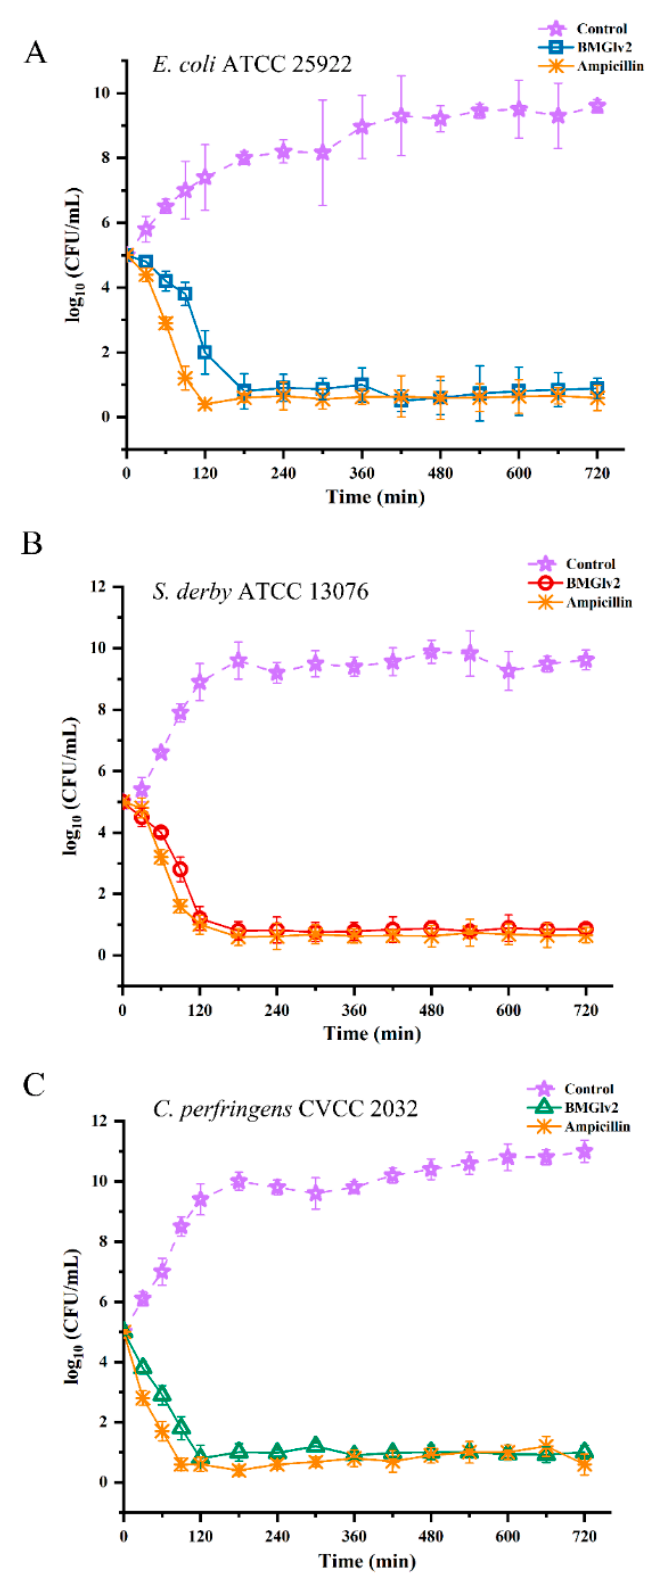
Figure 3. Time-kill curves of BMGlv2. ( A ) Time-kill curves of BMGlv2 against E. coli ATCC 25922. ( B ) Time-kill curves of BMGlv2 against S. derby ATCC 13076. ( C ) Time-kill curves of BMGlv2 against C. perfringens CVCC 2032. Results were given as the mean ±